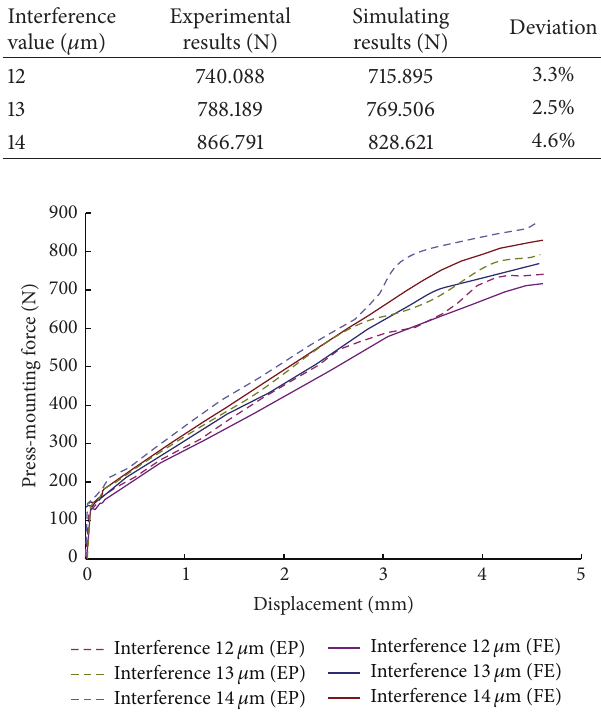
Figure 10: Comparison of the press-fit